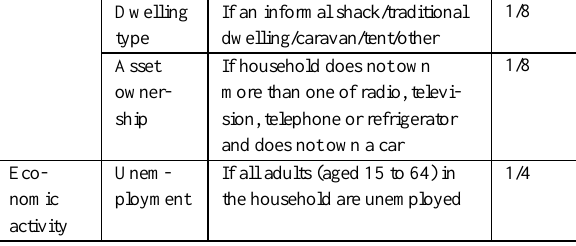
Table 1. Dimensions, indicators and deprivation cut-offs